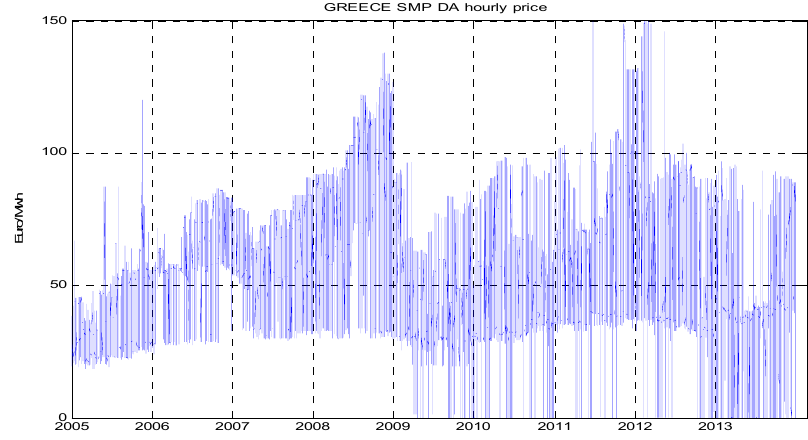
Figure 2. Greek electricity market, hourly day-ahead SMP, 2005–2013.